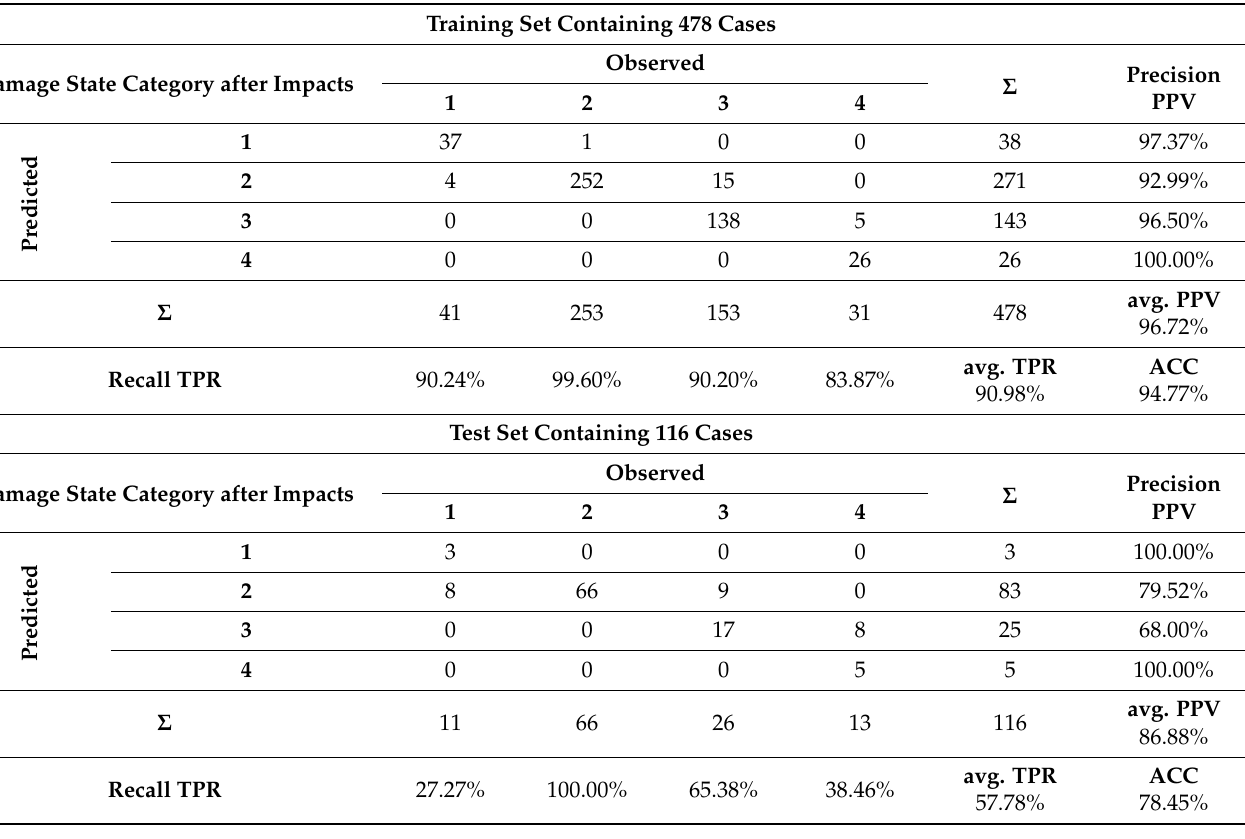
Table 3. Confusion matrix for the PNN classifier—Accuracy of classification, average precision and average recall for training and test